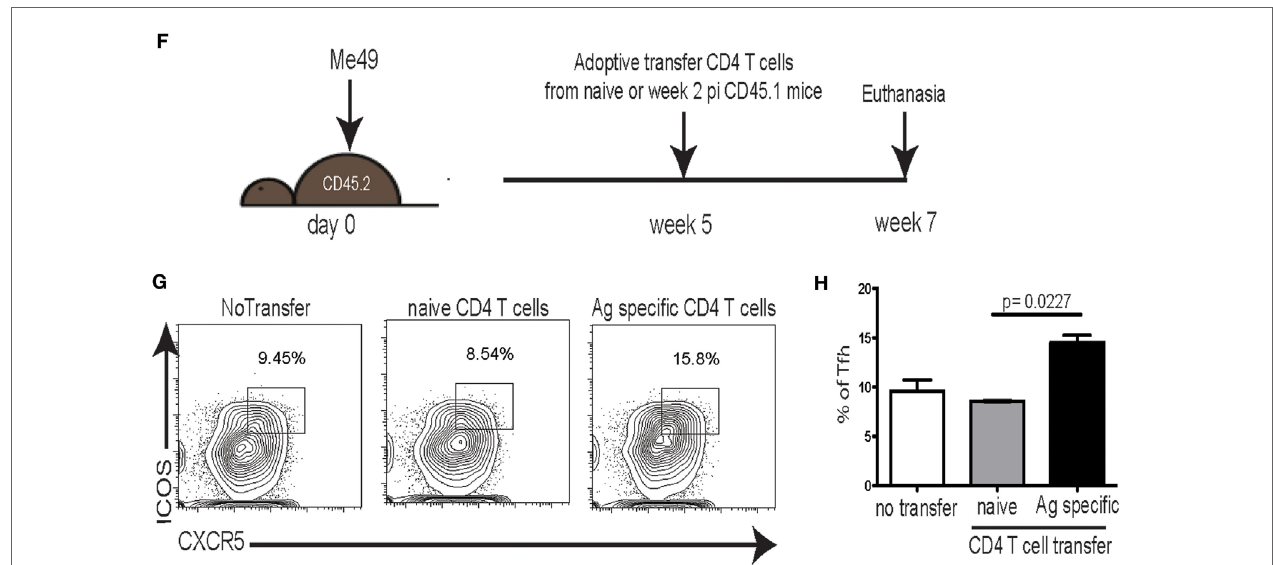
FigUre 3 | Increased CD8 T cell exhaustion is correlated with loss of IL-21 signaling. WT and IL-21R knockout (KO) animals were infected with 10 T. gondii cysts via the oral route and CD8 T cell response was analyzed for function and expression of inhibitory receptors at week 7 p.i. (a–B) CD8 polyfunctional capability (IFN γ , CD107a, and TNF α ) was analyzed after overnight stimulation with Toxoplasma lysate antigen (a) . Plots represent CD44 hi CD11a hi CD8 T cells. Frequency and total number of CD44 hi CD11a hi CD8 T cells expressing IFN γ /CD107 α or IFN γ /TNF α are presented (B) . Expression of inhibitory receptors (PD-1, LAG-3, Tim-3, and 2B4) by antigen-specific CD8 T cells (CD44 hi CD11a hi ) was measured by flow cytometry analysis (c) . Graphs compare the MFI for each marker between WT and IL-21R KO CD8 Tells from naïve and infected animals (D) . SPICE pie chart shows the co-expression of the different exhaustion markers for antigen-specific CD8 T cells from WT and IL-21R KO (e) . Transfer strategy of T. gondii -specific non-exhausted CD4 T cells to mice carrying chronic infection. CD45.2 animals (infected 5 weeks before transfer) received T. gondii -specific non-exhausted CD4 T cells (CD4 + CD11a hi CD49d hi ) isolated at week 2 p.i. or non-specific CD4 T cells (CD4 + CD11a lo CD49d lo ) from CD45.1 donors (1 × 10 6 cells/mouse via iv. injection) (F) . T. gondii -specific splenic Tfh were analyzed in the spleen of recipients at week 7 p.i. (2 weeks post-transfer) (g) . Bar graph represents the percentage of Tfh among antigen-specific CD4 T cells from the recipient (h) . Experiments were